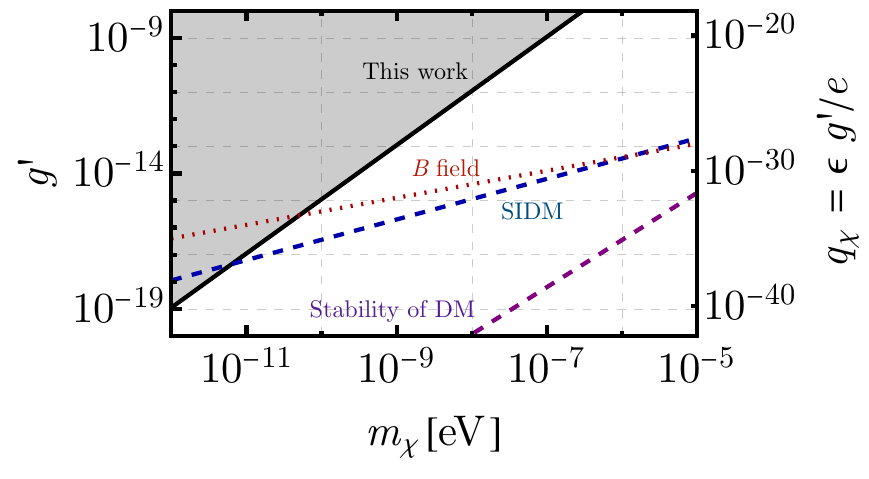
Figure 3 . Parameter space of darkly charged particles (DCPs), given a coupling g 0 to a dark photon (assumed massless). As in figure 2, the Festina-Lente bound places the black shaded region in the Swampland. Different dashed lines show constraints for DCPs if they compose the entirety of the DM, and come from self interactions (blue [36]), stability arguments (purple [50]), and from magnetic fields (red [59], where we assume an induced millicharge q χ given by the standard 1-loop value for the kinetic mixing (cid:15) = e g 0 / (16 π 2 )